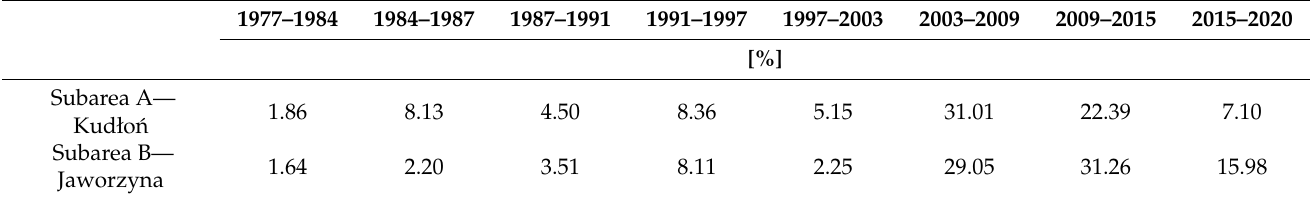
Table 5. Dynamics Index of analyzed time periods in subareas A—the Kudło´n and B—the Jaworzyna range.